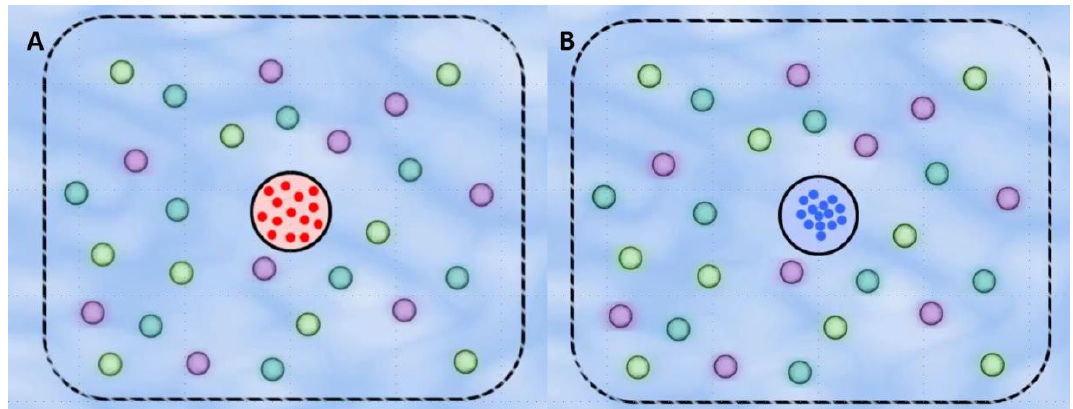
Figure 1. Schematic of our water quality detection prototype in the absence and presence of E. coli bacteria. The device contains three types of microspheres. The purple microspheres contain lysozyme, which lyses the cell walls of bacteria, releasing their DNA. The light green and blue microspheres contain the H1 and H2 DNA releasing probes, respectively. These probes bind to a specific region of the E. coli genome, which forms a DNA complex. ( A ) The detector region in the middle consists of gold nanoparticles which, in the absence of DNA complexes, appear red. ( B ) The presence of these DNA complexes causes the detector region shown in the middle of the device to change from red to blue as the nanoparticles aggregate.